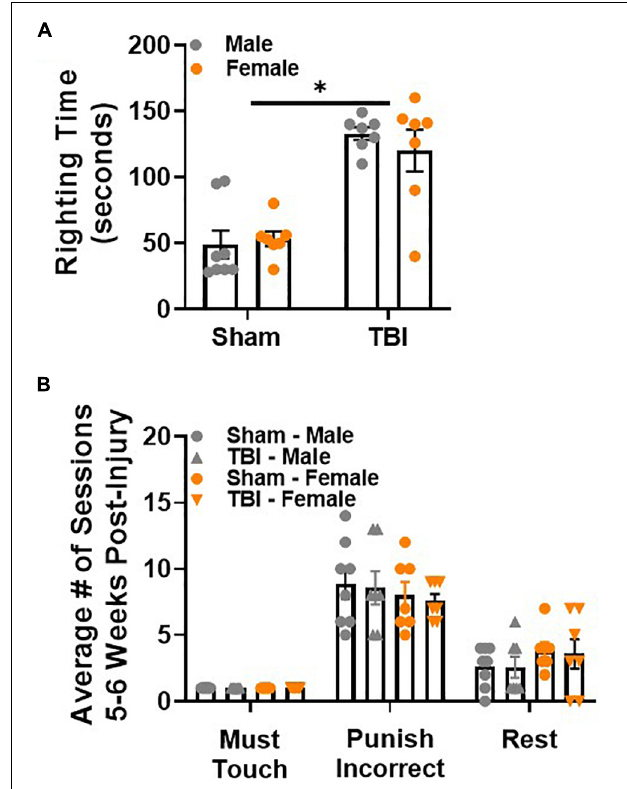
FIGURE 2 | Paired associate learning procedural memory is intact after sham injury or TBI. (A) TBI induces a longer righting time than sham injury. (B) Sham and TBI mice, regardless of sex, perform similarly on procedural PAL tasks 5 weeks post-injury. N = 7–8/group; error bars indicate SEM. Main effects are identified in the figure, unless an interaction effect was identified. ∗ p <